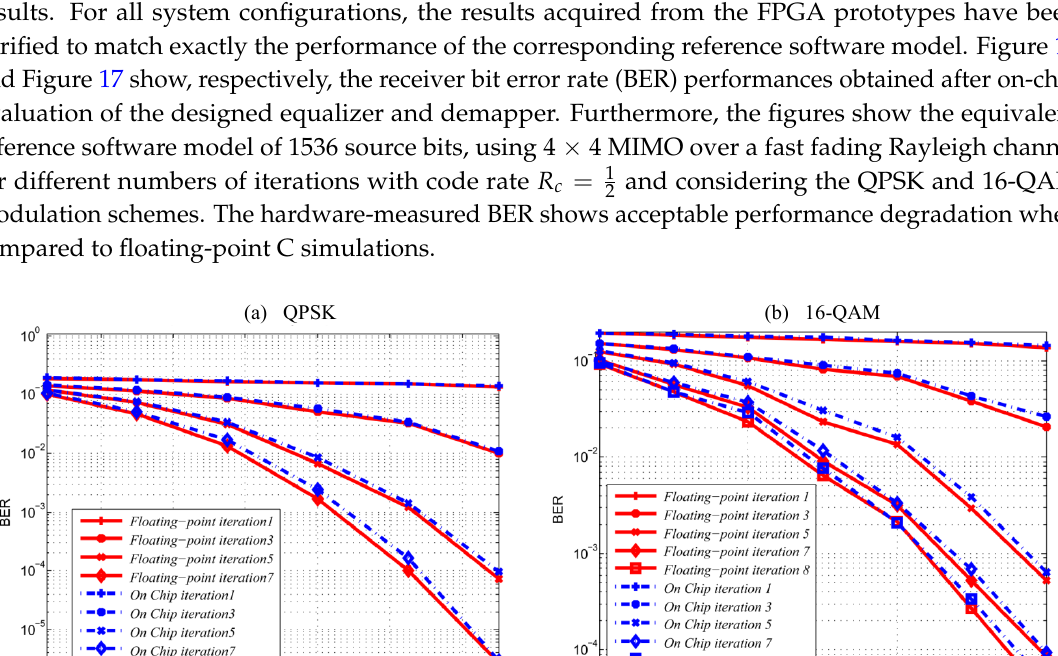
code rate, 4 × 4 MIMO and a fast fading 2